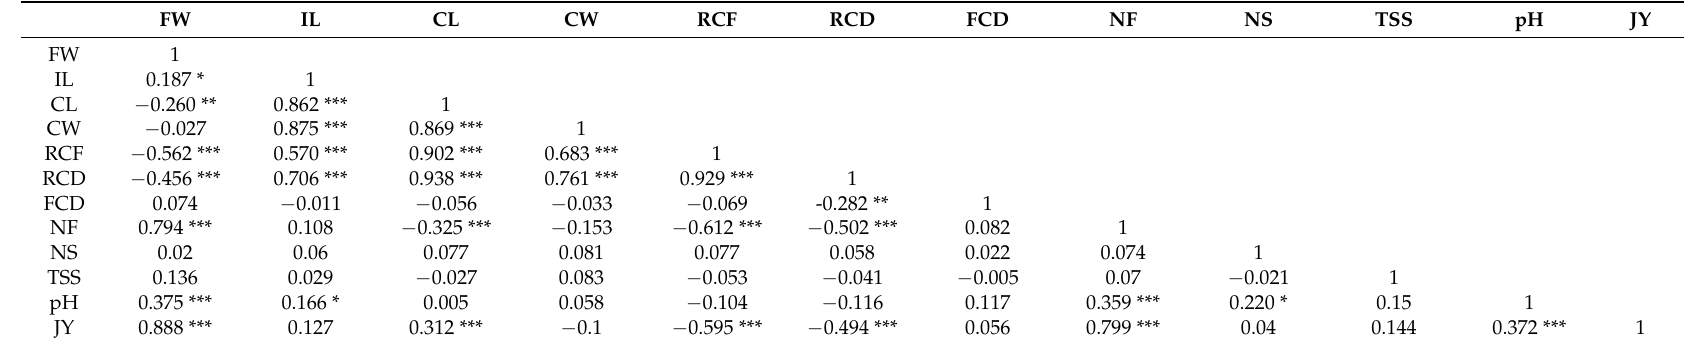
Table 3. Correlation between fruit quality attributes for